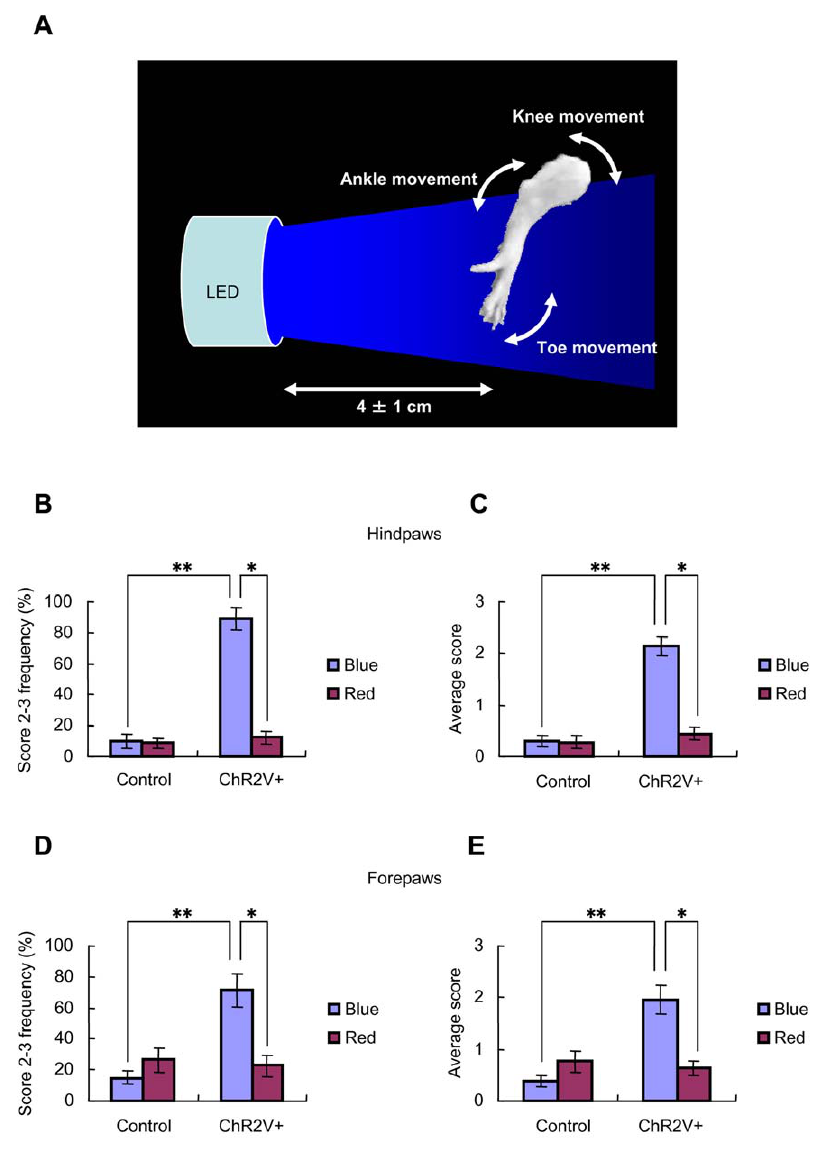
Figure 6. Optically evoked behavioral responses. A. Schematic diagram of the experimental setup. One of four paws was placed in the light path of a blue or red LED so that the plantar skin faced the light while the rest of the body was covered with a black cloth. The distance between the surface of the collimator lens of the LED and the plantar skin was set to about 4 cm, but the exact distance was in the range of 3–5 cm because of the spontaneous movements of the paw. All the experiments were carried out under yellow, dim background light. The optically evoked behavioral responses were scored according to the movement around joints: toe, ankle/wrist or knee/elbow (Table 1). B and C. Light-evoked responses of hindpaws were compared between the wild-type (n=8) and the ChR2V + rats (n=8). The probability of large movements (score 2–3, B) or the average score over ten successive tests (C) was compared between blue and red LED light. D and E. Light-evoked responses of forepaws of the same group of rats: the probability of large movements (score 2–3, D) or the average score (E). Wicoxon signed-rank test was applied for the paired data (*, P , 0.01) and Mann-Whitney U -test for unpaired data (**, P , 0.0005).